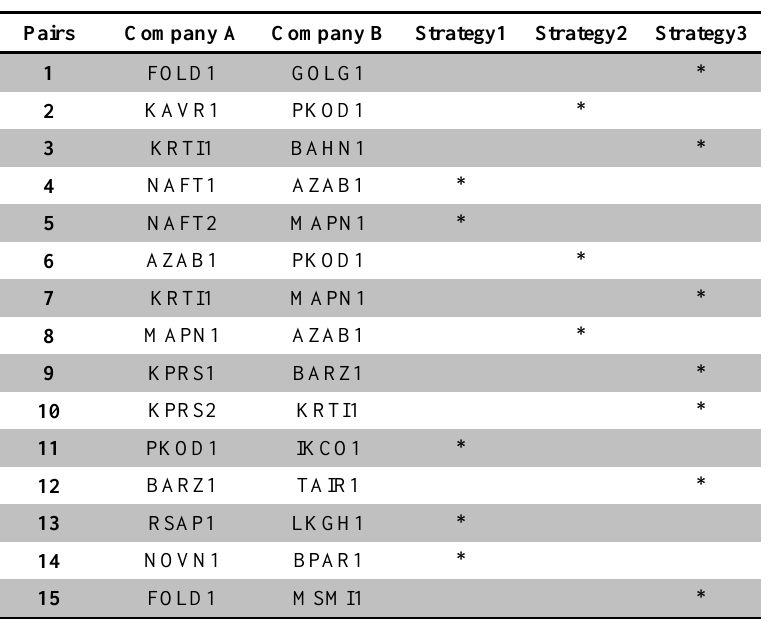
Optimized strategy for each